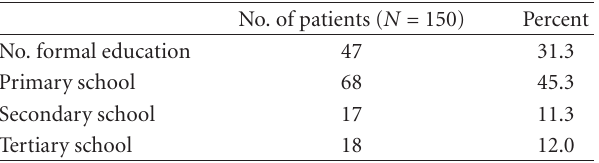
Table 1: Educational attainment of